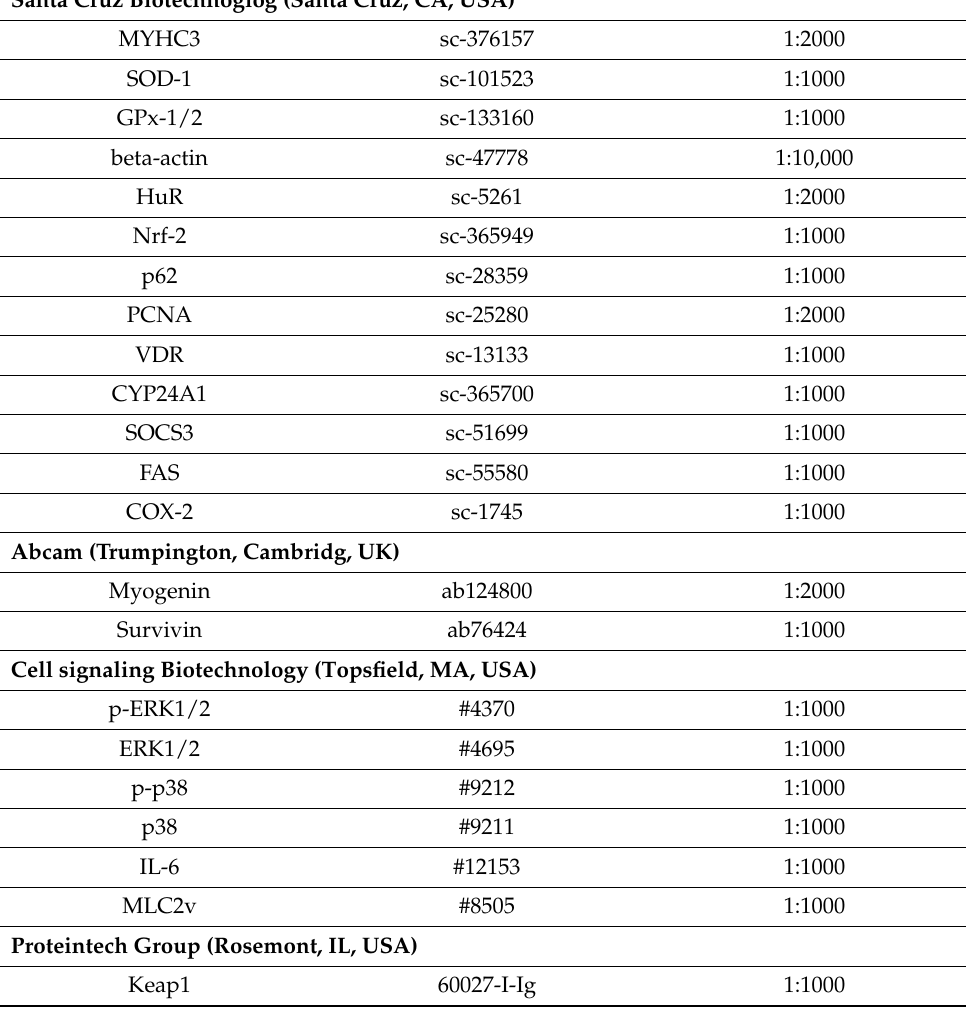
Table 1. Antibodies used for this